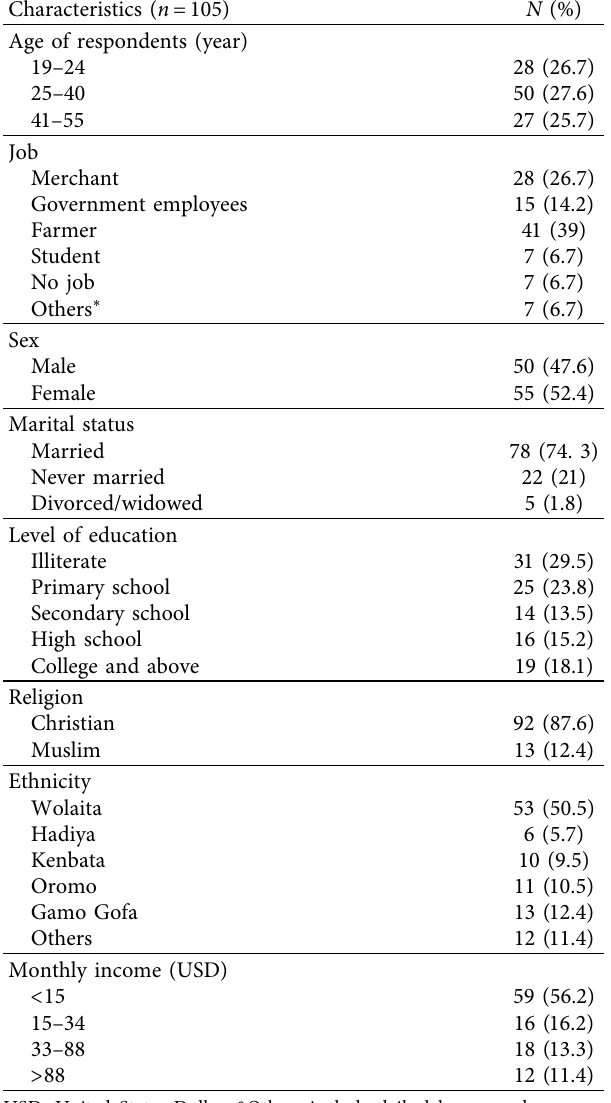
Table 1: General characteristics of respondents at hospitals in Wolaita zone, Southern Ethiopia, October 2016.